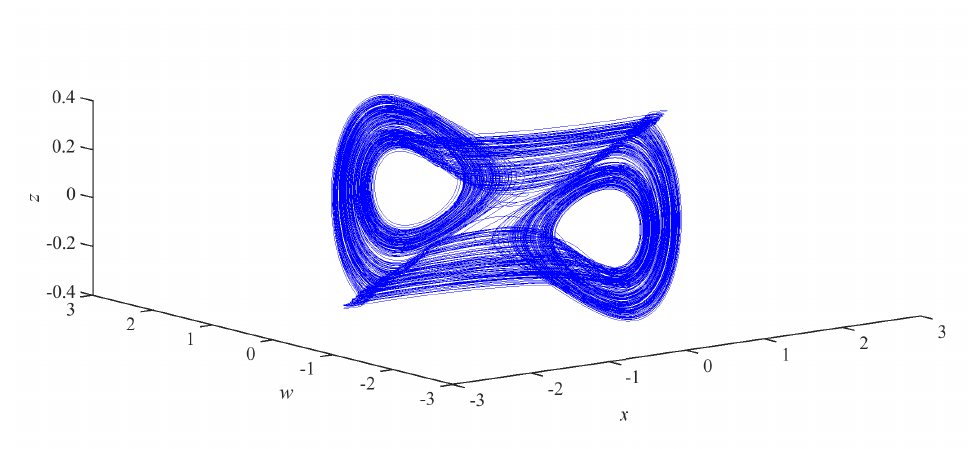
Figure 2. The three-dimensional phase portrait of the chaotic circuit system.